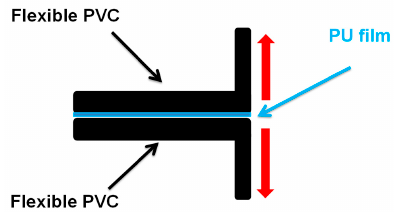
Figure 4. Scheme of T-peel test of plasticized poly(vinyl chloride (PVC) / PUD / plasticized PVC